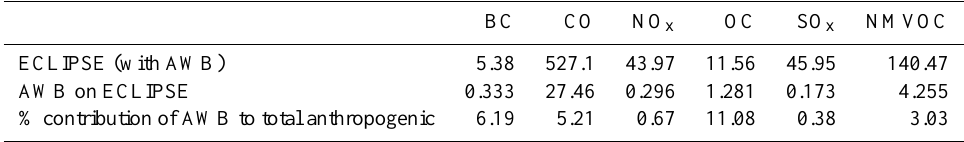
Table 1. Anthropogenic emissions (Tga − 1 ) used in this study and fraction of emissions that corresponds to the AWB sector included in the ECLIPSE anthropogenic emissions inventory. Both absolute quantities and percentage of the total anthropogenic emissions from Klimont et al. (2013) are presented.